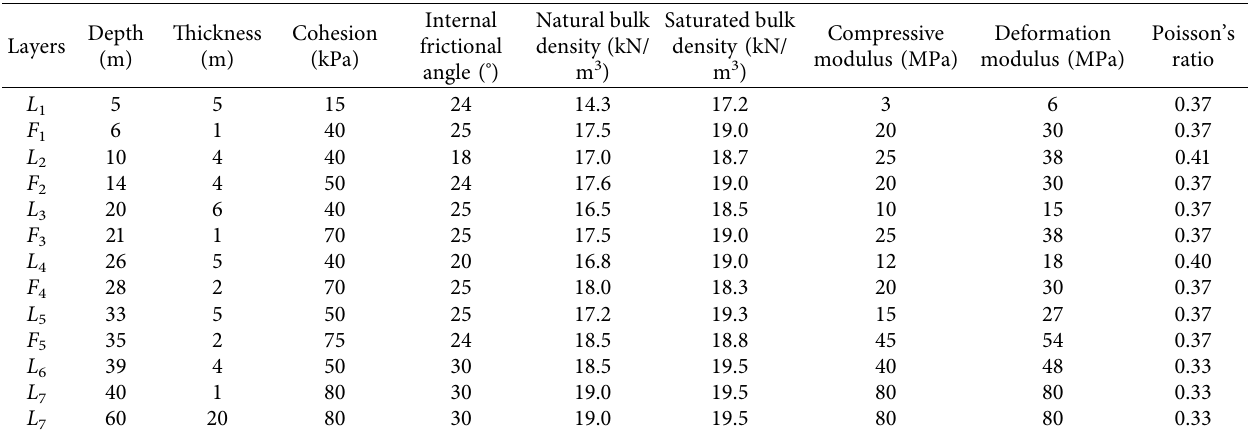
Table 6: The calculation parameters of various soil